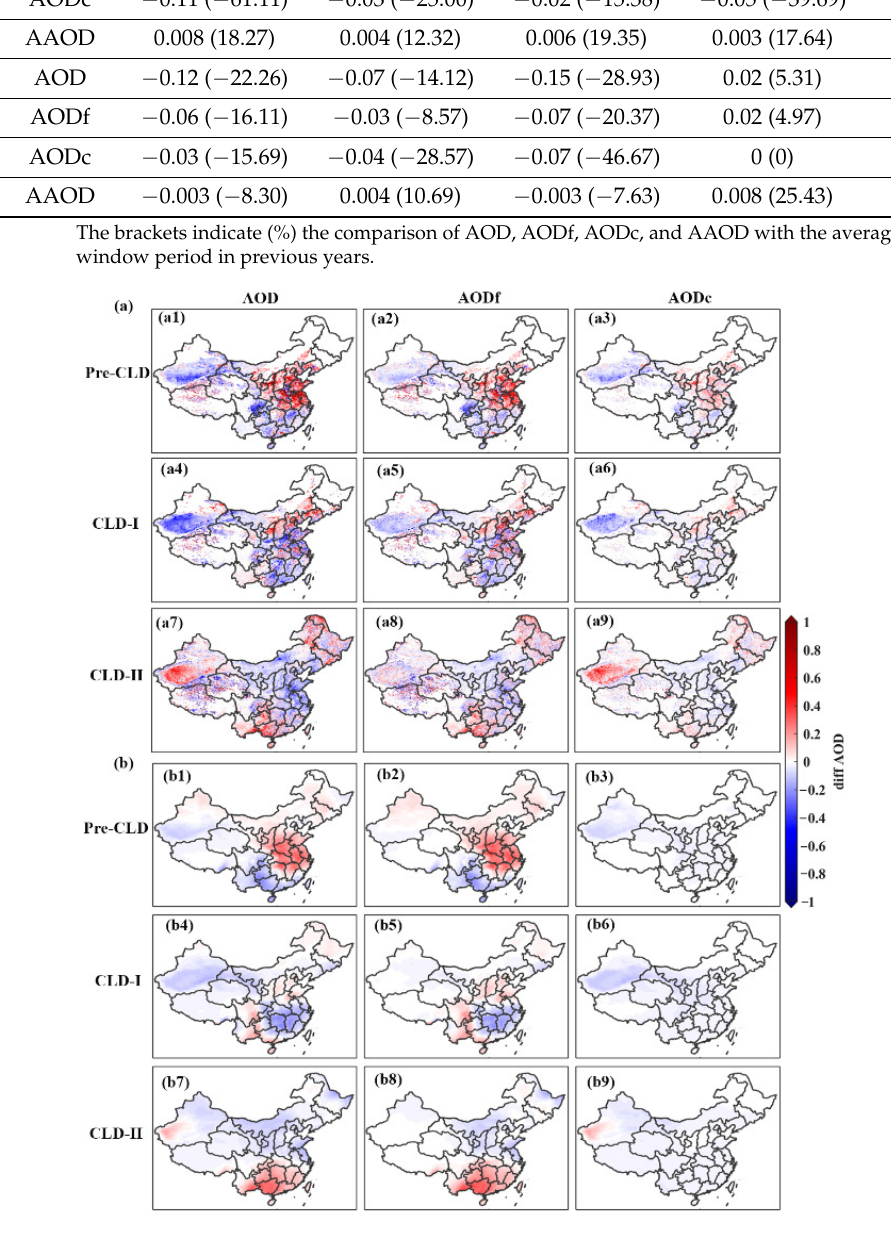
Figure 3. ( a ) The AOD, AODf, and AODc retrieved by MODIS are compared with the 3-year average (2017–2019) of the same window in previous years during the Pre-CLD ( a1 – a3 ), CLD-I ( a4 – a6 ), and CLD-II ( a7 – a9 ) periods. ( b ) Same comparison as ( a ), but for MERRA-2